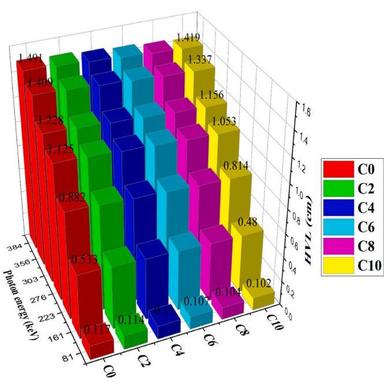
Variation of half value layer (HVL) against photon energy for the glasses.